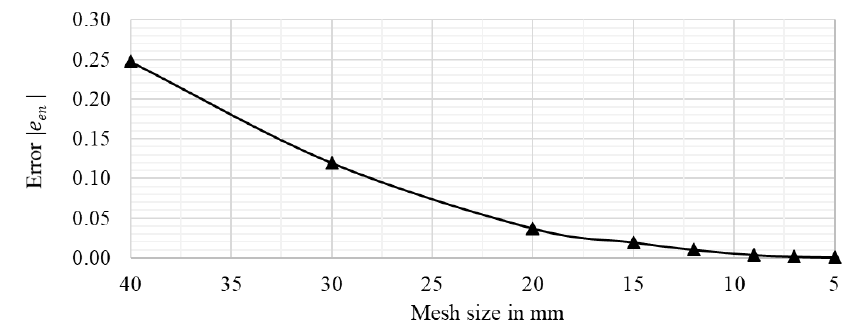
(cid:12) (cid:12) (cid:12) (cid:12) (cid:12) e en (cid:12) , calculated as the di ff erence of the solved